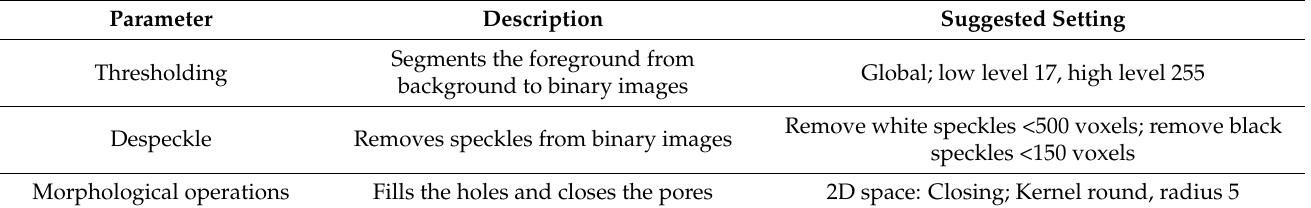
Figure 5. Images of the various steps related with μ -XCT methodology: ( a ) scanning procedure; ( b ) after reconstruction process; ( c ) analysis—binary image; ( d ) binary treated image ready for calculation. Table 3. Image processing algorithm used to segment 3D images.